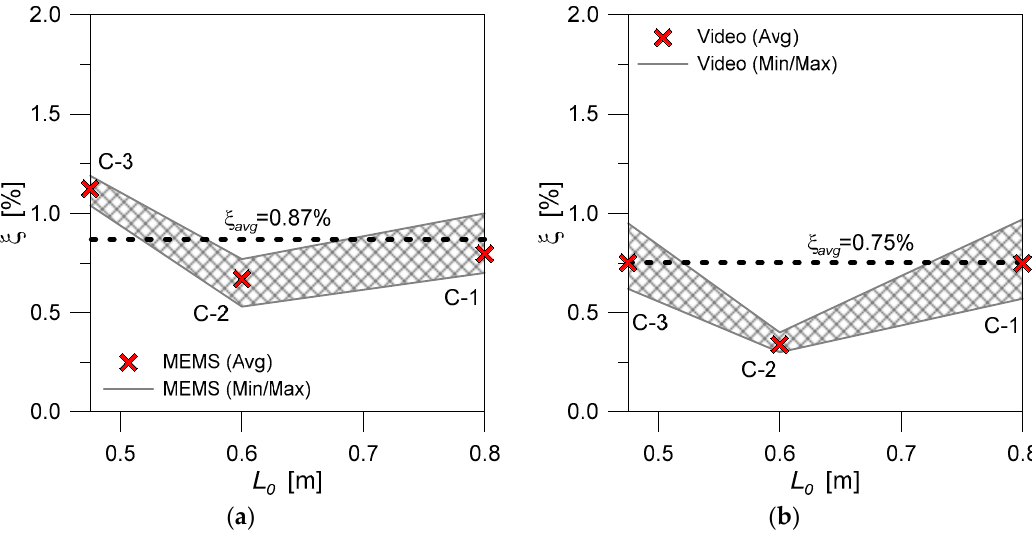
Figure 10. Experimentally derived damping ratio ξ for the tested glass samples, as obtained from post-processing of ( a ) MEMS records and ( b ) video-camera acquisitions. Data referred to C-type samples.